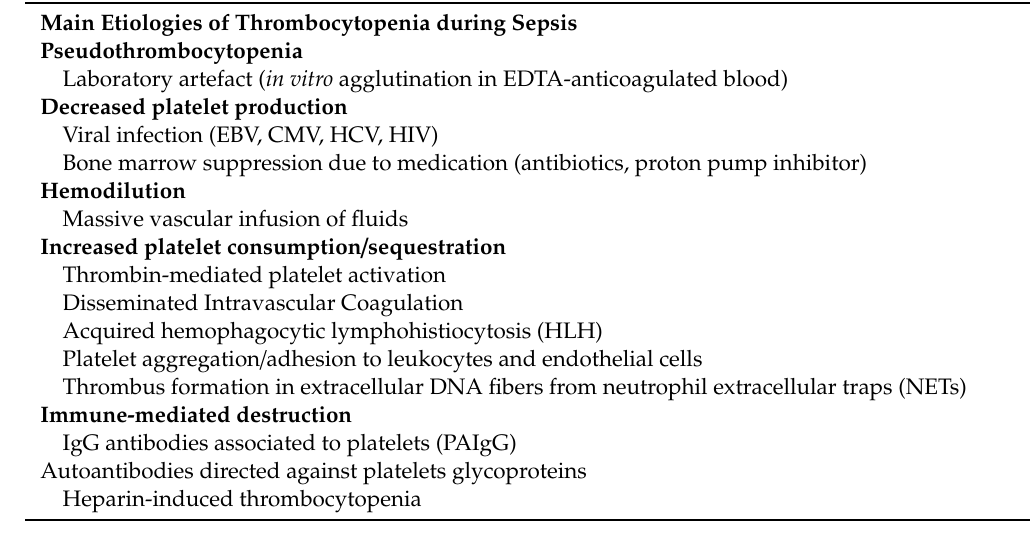
Table 1. Etiologies of thrombocytopenia during